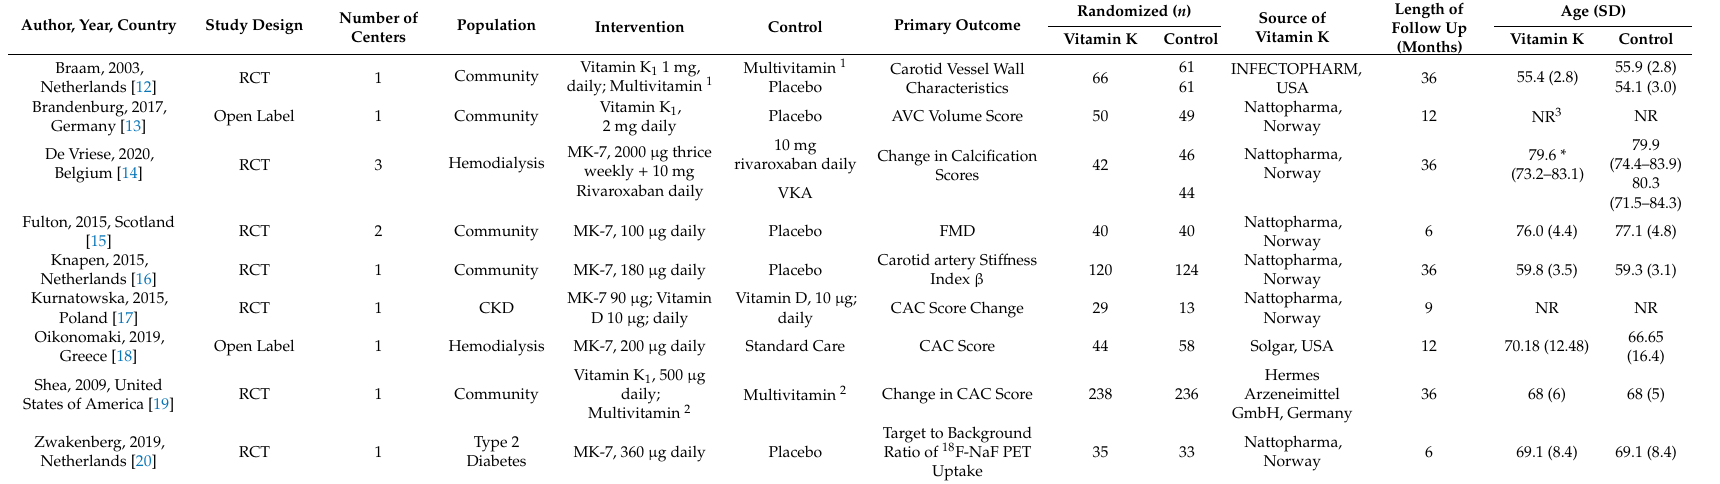
Table 2. Study characteristics of included